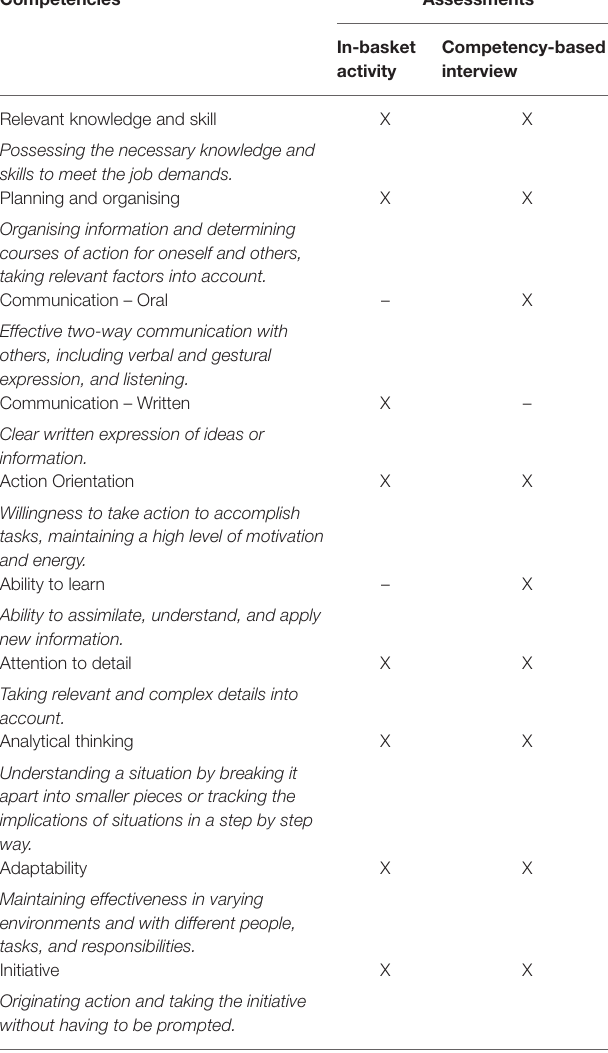
TABLE 2 | Competency